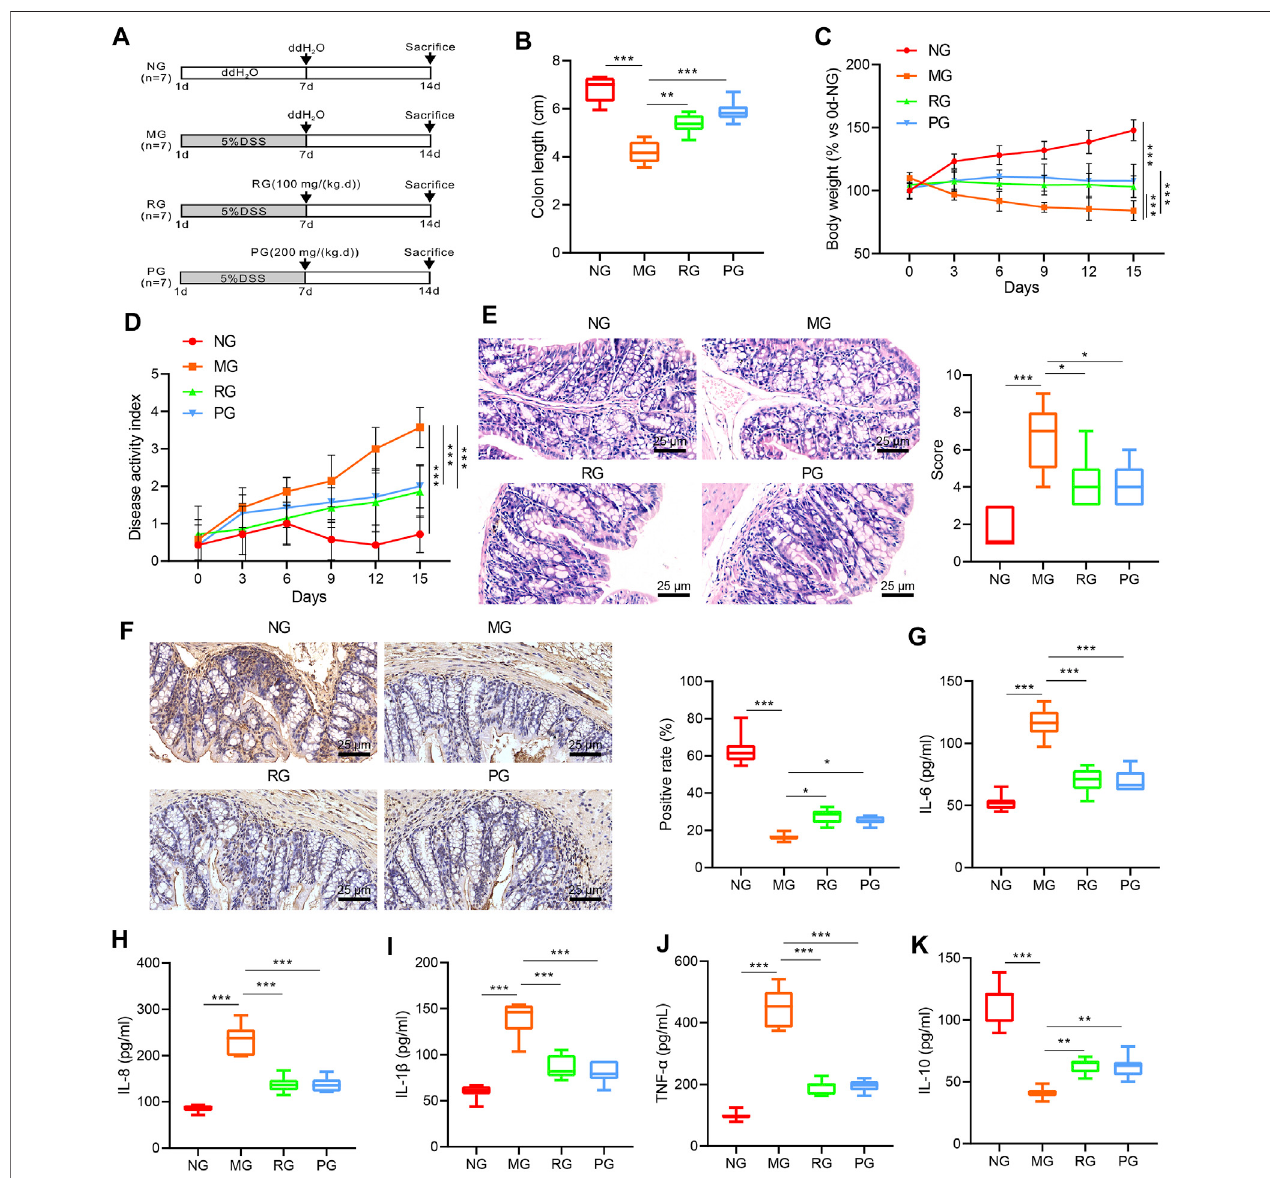
tissues of mice in different treatment groups was monitored using ELISA. n (cid:1) 20. Measurement data were expressed by mean ± SD. One-way ANOVA or repeated measures ANOVA was conducted for multiple group comparison, followed by Tukey ’ s post hoc test. * p < 0.05, ** p < 0.01, and *** p < 0.001. NG, normal control group; MG, model control group; RG, resveratrol group; PG, positive control